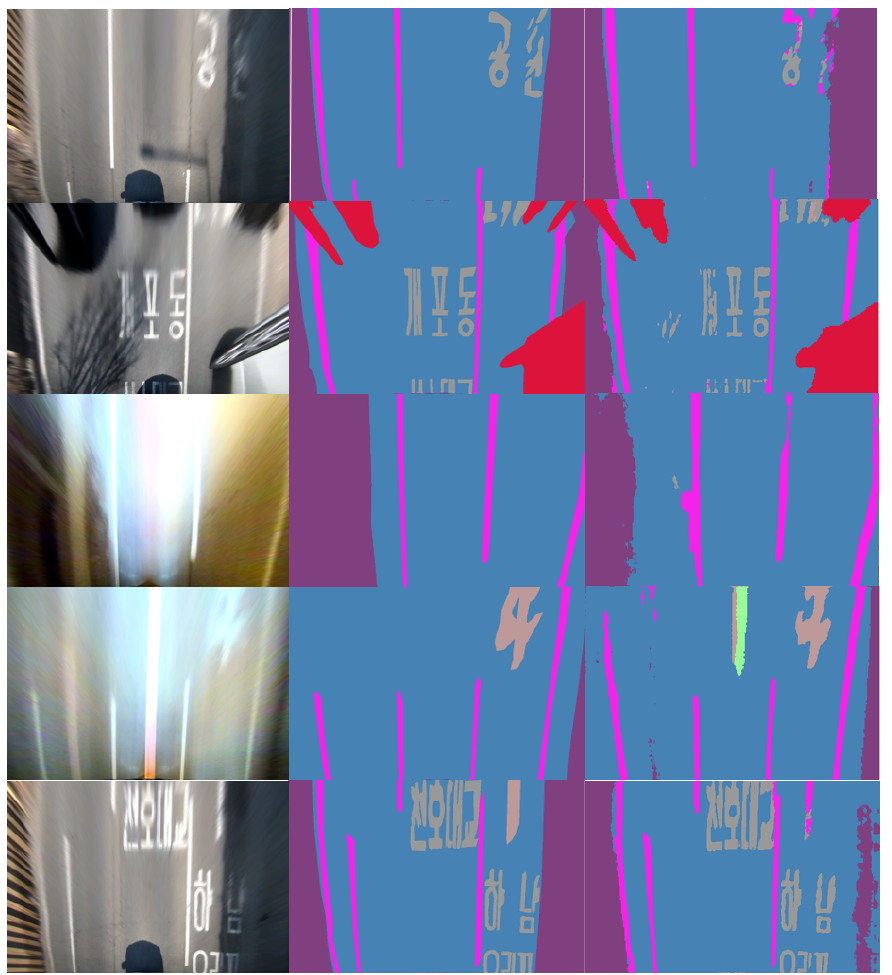
Figure 15. Examples of false-positive images on the Hyundai Motor Group (HMG)